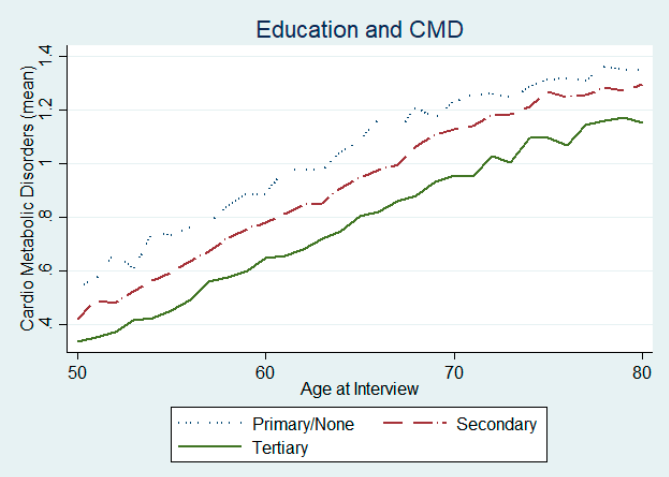
Figure 4. Chronic CMDs and level of education.